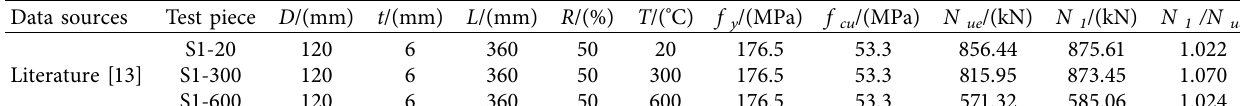
Table 3: Specific parameters of each specimen in the literature. Data sources